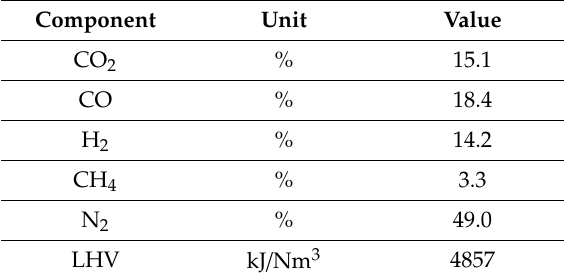
Figure 2. Retort burner for gasification of pellets: ( a ) view of the burner structure, ( b ) burner model in a cylindrical chamber, ( c ) burner model.